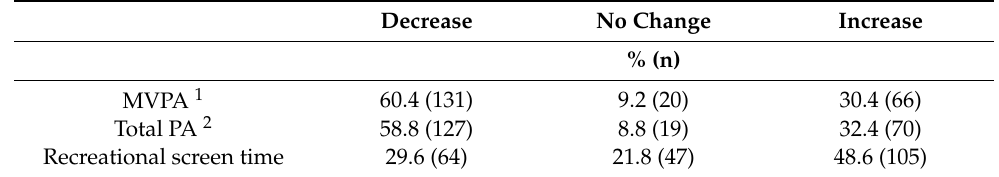
Table 3. Unadjusted Percentages of Participants who Experienced Decreases, No Changes,